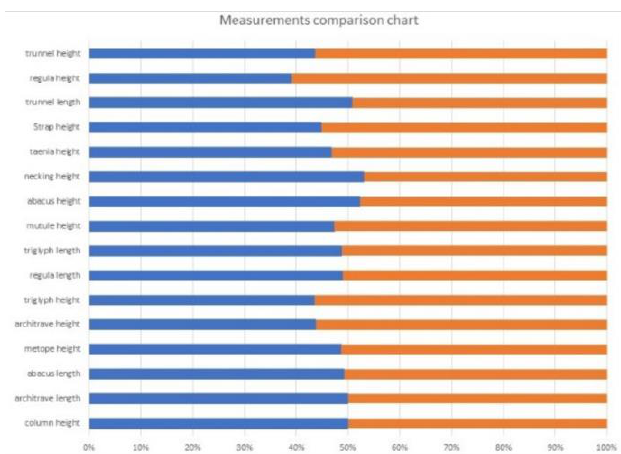
Figure 11. Comparison chart of dimensions between standard column and point cloud (source: Kontoudaki,